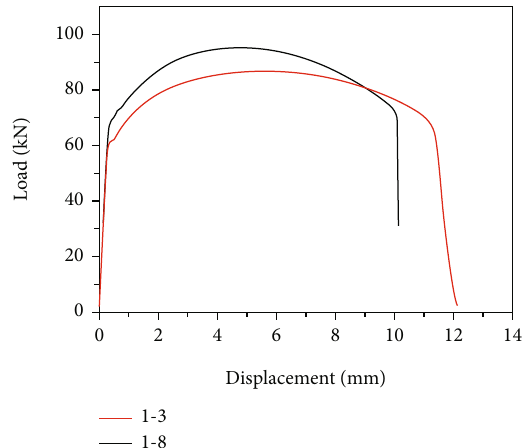
Figure 12: Tensile load-displacement curves of serviced bridge deck samples.